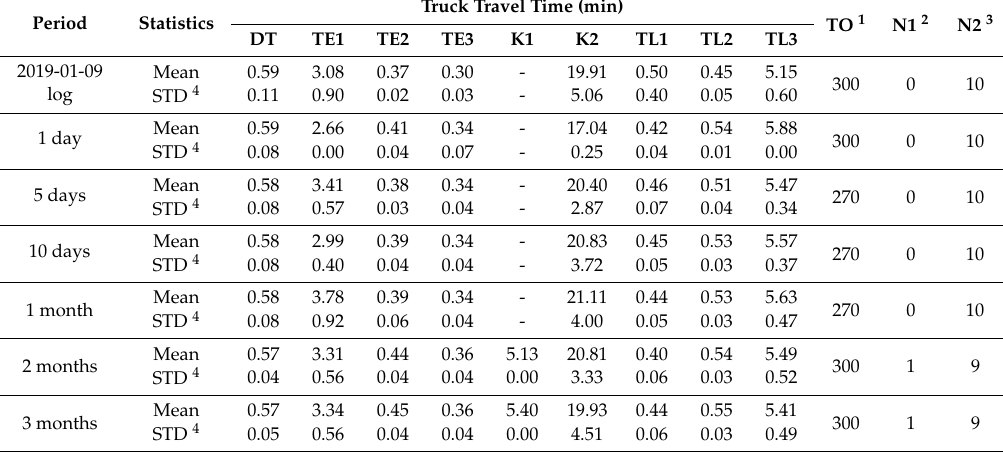
Table 9. Comparison of the simulation results by data collection period and the haulage operation performed on